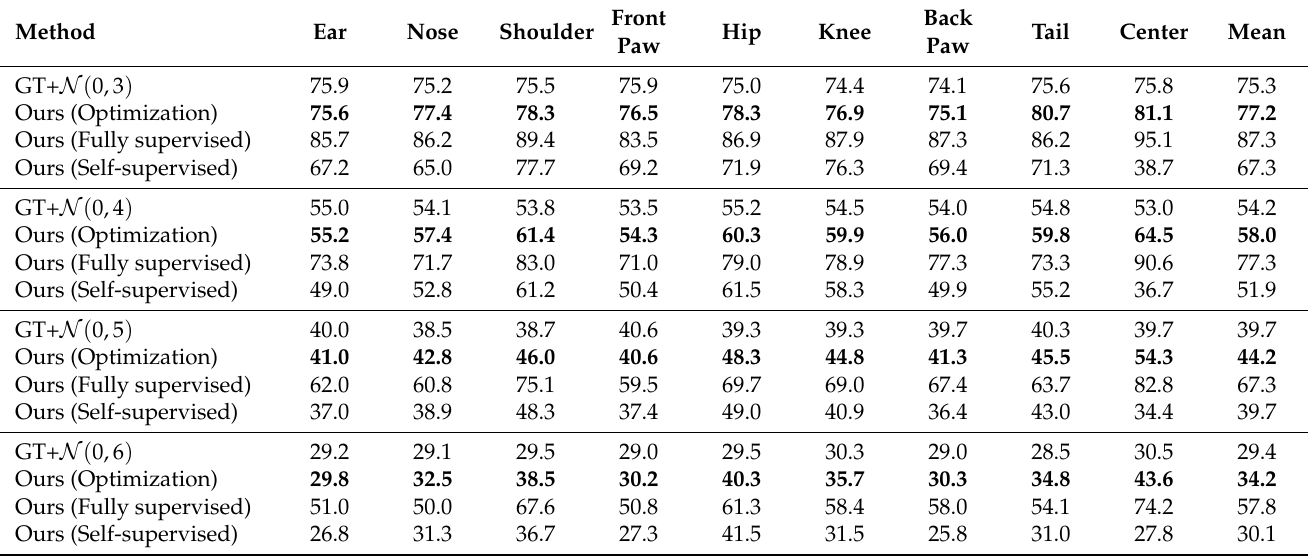
Table 2. PCK@0.05 accuracy on SA-Tiger with different levels of Gaussian noise added to the ground truth(GT) pose (%). The best results are marked in